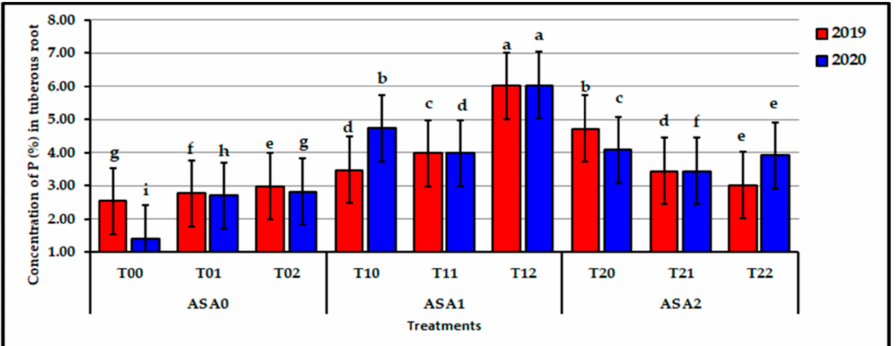
Figure 3. Influence of interaction between zinc oxide nanoparticles and ascorbic acid on root P content of stressed sweet potato plants in 2019 and 2020 seasons. Bars with a different letter indicate significant difference between treatments at p ≤ 0.05.